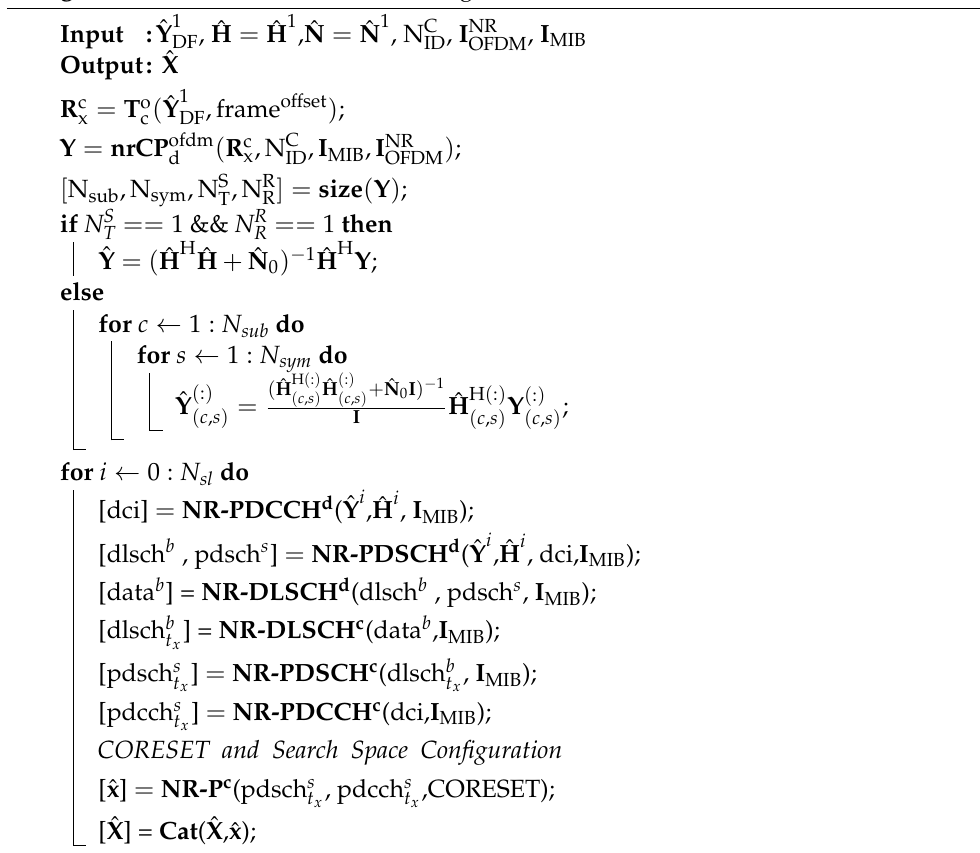
Algorithm 1: NR Decode-&-Encode